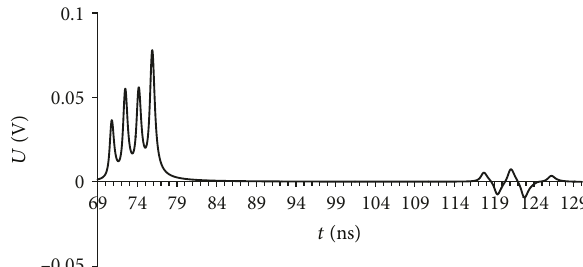
–0.0500.05 Figure 14: Simulated waveform at the far end of the probing line ( 𝑉4 ) of the structure with a passive wire break when 𝑅2 = 𝑅4 = ∞